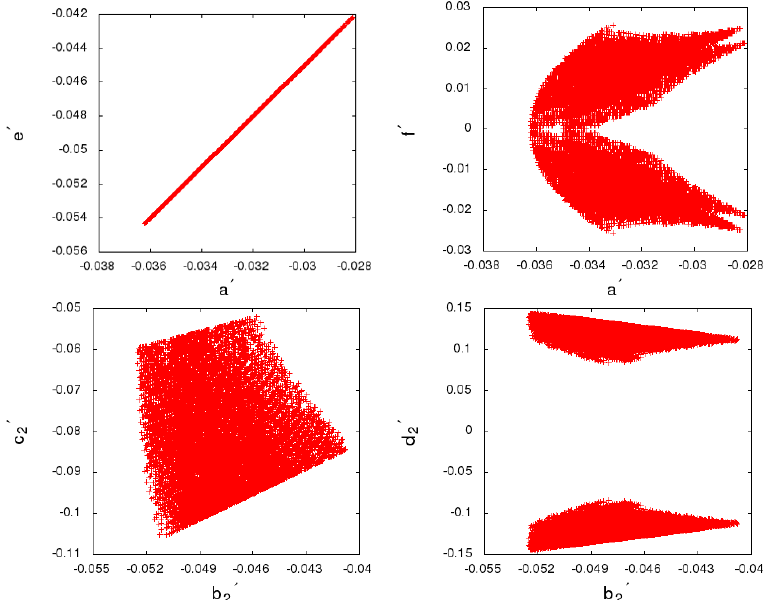
Figure 1 . Case-I: plots of the primed parameters for a normal mass hierarchy.